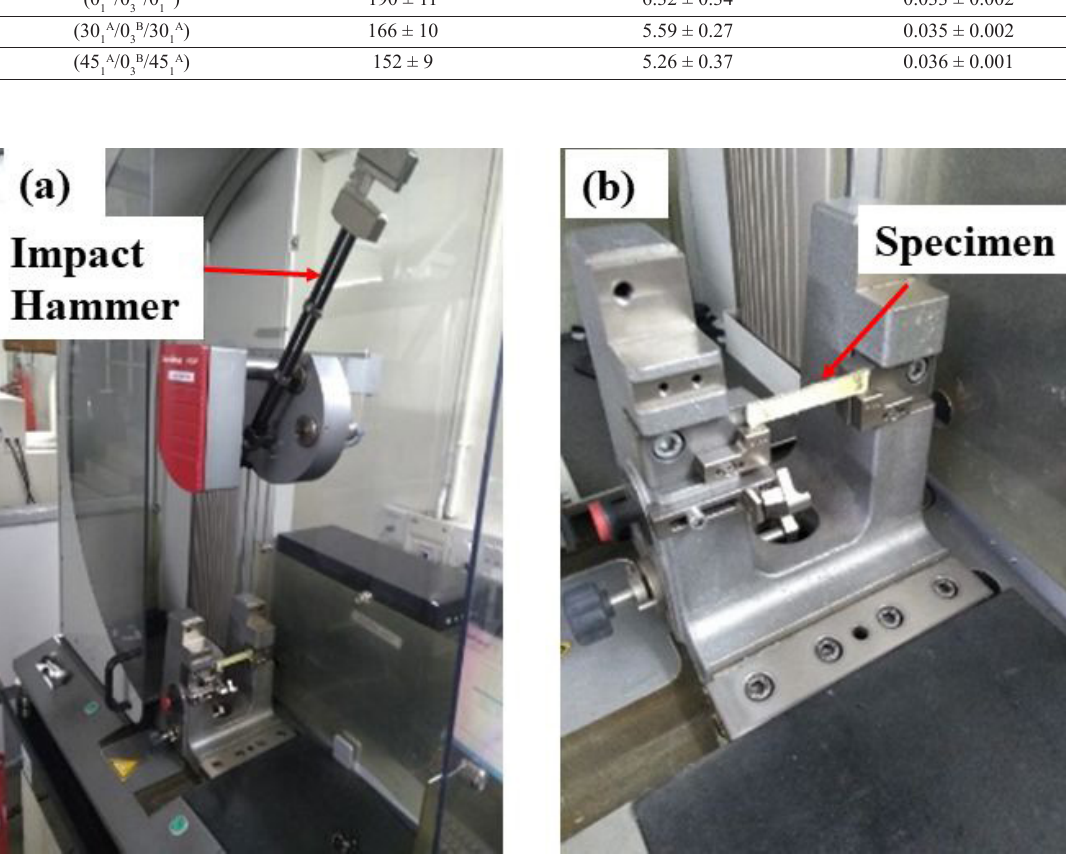
Table 3. Tensile test results of hybrid composites. Composites